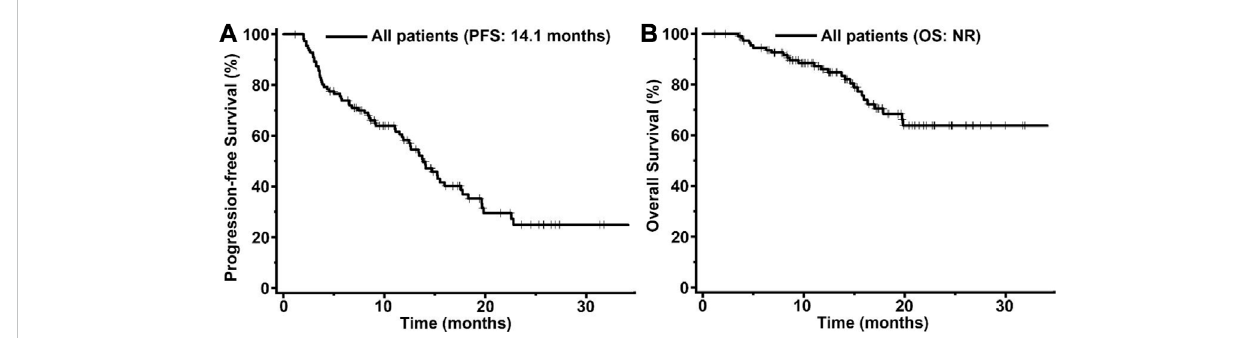
FIGURE 2 Kaplan-Meiercurvesofprogression-freesurvival(PFS, (A) andoverallsurvival(OS, (B) forpatientswithHER2-positiveMBCtreatedwithpyrotinib( n = 113). The tick marks indicate the time points at which the data were censored. NR, not reached.